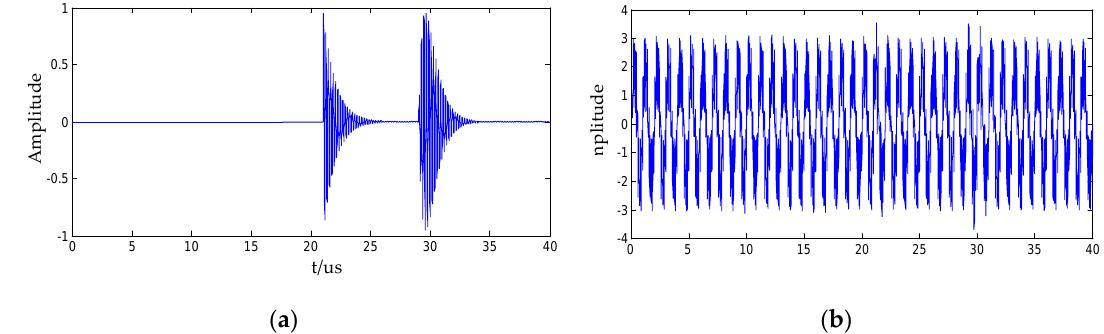
Figure 4. Simulate cable partial discharge (PD) signals. ( a ) Clear cable PD signal. ( b ) Noisy cable PD signal.